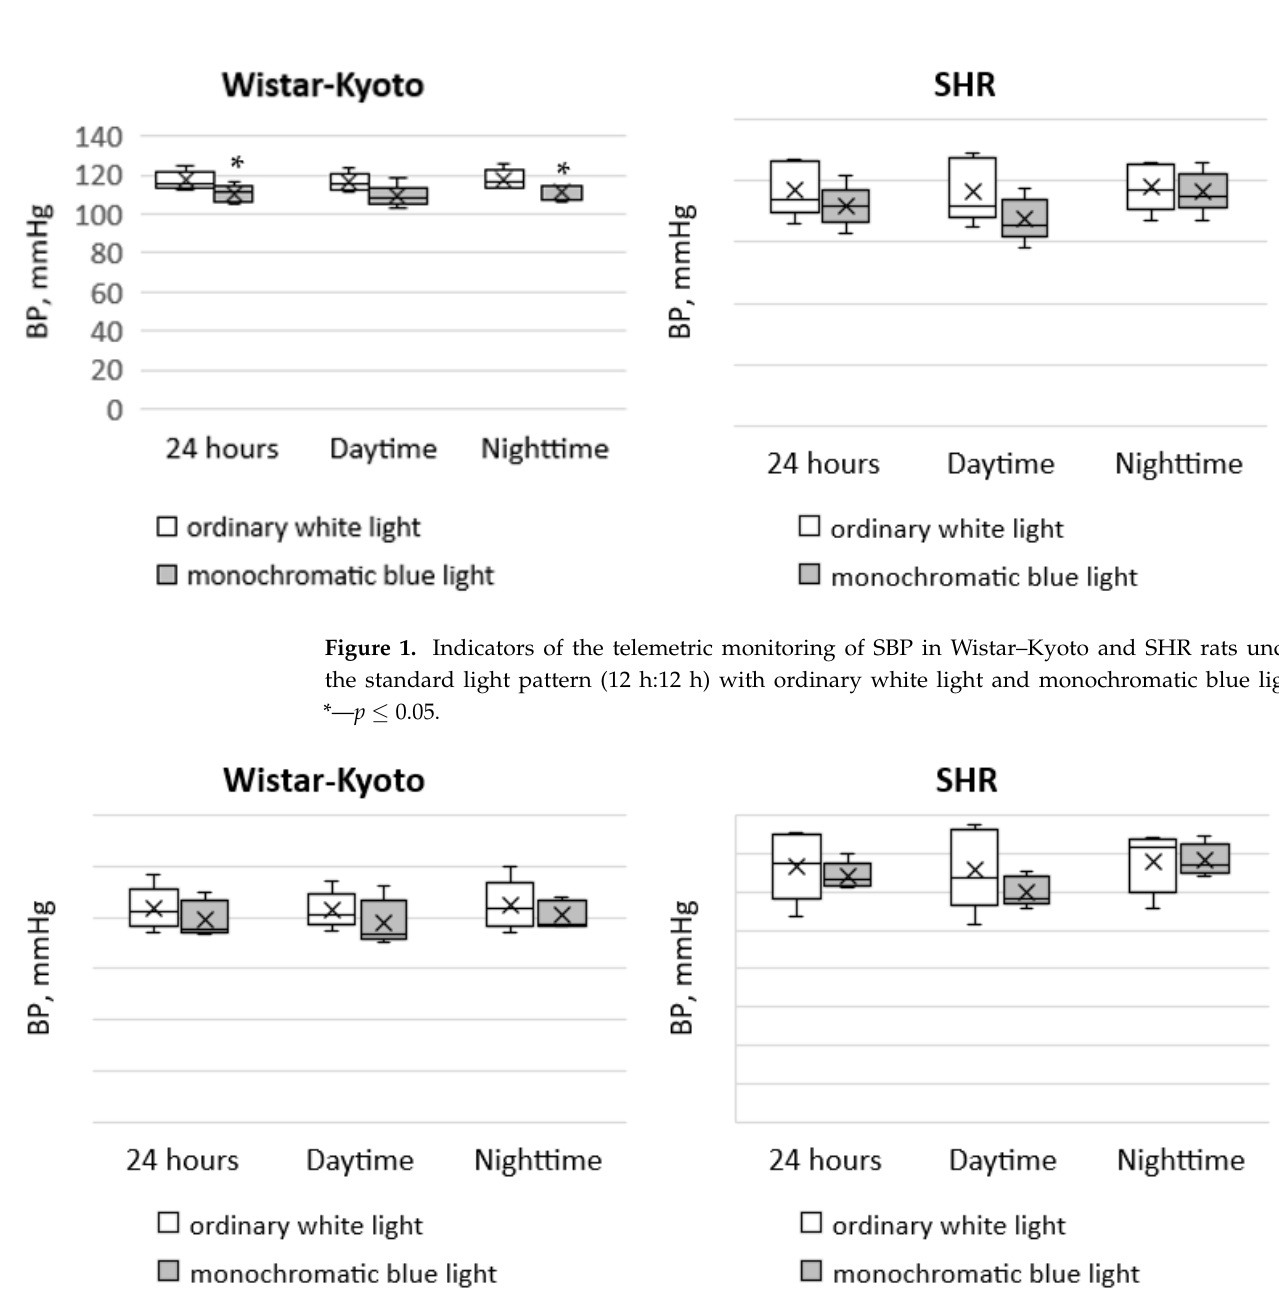
Figure 2. Indicators of the telemetric monitoring of DBP in Wistar–Kyoto and SHR rats under the standard light pattern (12 h:12 h) with ordinary white light and monochromatic blue light.